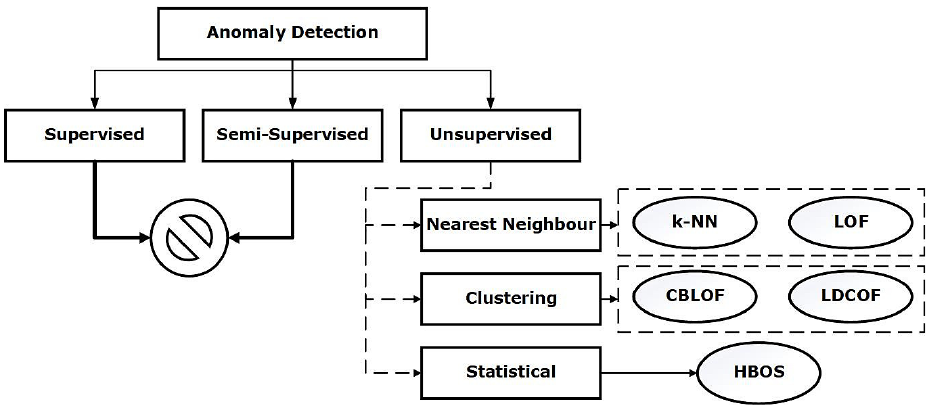
Figure 6. Anomaly detection algorithms.